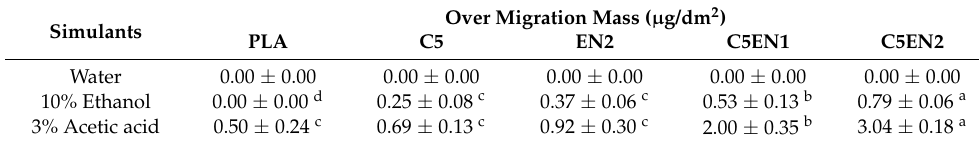
Table 3. Overall migration mass of PLA and PLA composite films into various food simulants.